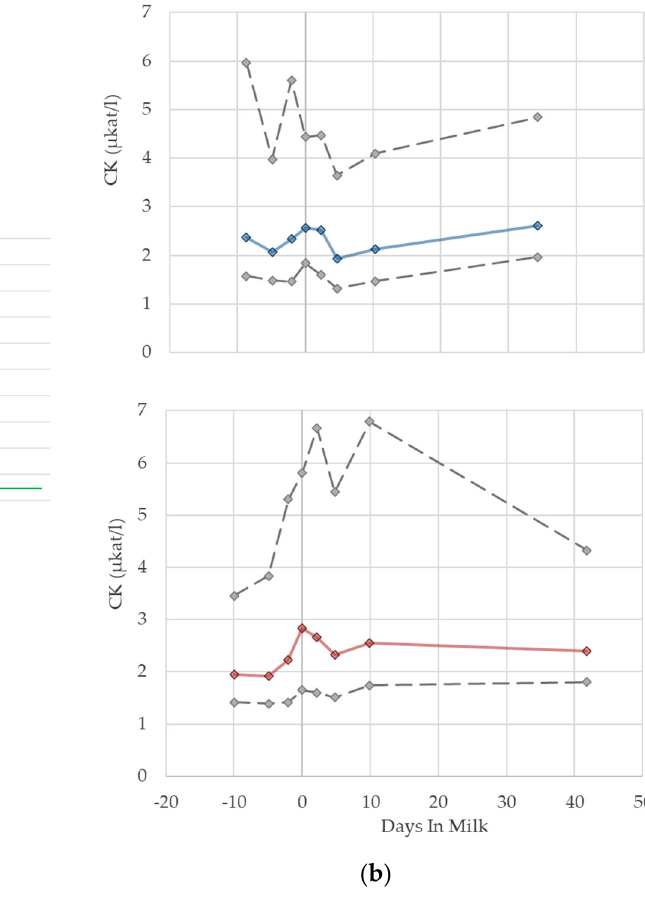
Figure 7. Serum activities of creatine kinase (CK) in primiparous (blue), and in multiparous (red) cows ( a ) in 10 classes between 30 days prepartum to 300 days postpartum (boxplots), green continuous lines represent the reference values according to Fürll [23], asterisk indicates significant differences regarding parity within DIM class; and ( b ) in 8 classes from 10 days prepartum to 40 days postpartum (median—continuous line; 1st and 3rd quartile—dashed lines; percentile 5 and 95—dotted lines).